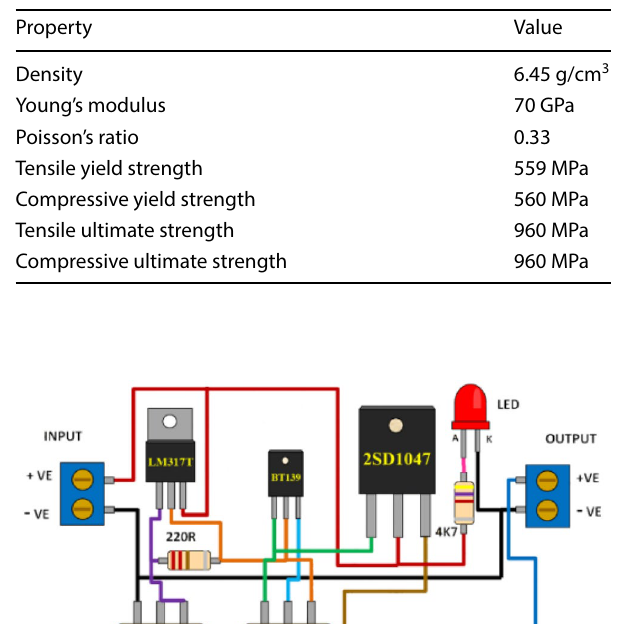
Table 3 FDM process parameter values